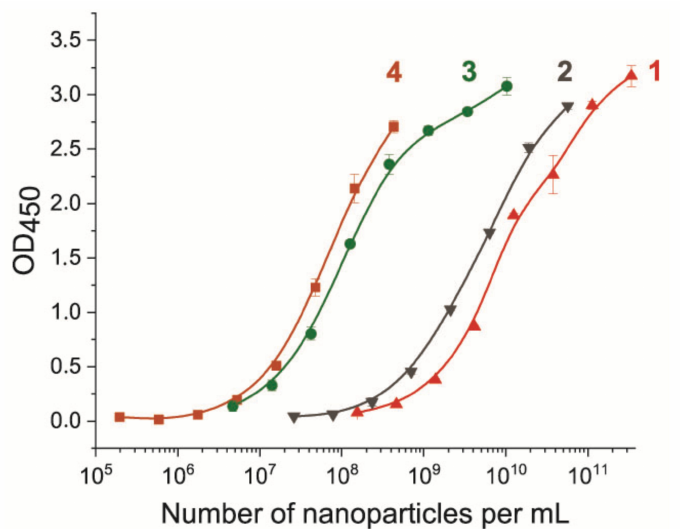
Figure 5. Binding dependencies of the pAb-nanoparticle conjugates to the bacterial cell (10 8 CFU/mL of E. amylovora ) adsorbed on the microplate surface. Numbers correspond to the type of nanoparticles: 1—Au NPs, 2—Au@Pt NPs, 3—LPs,